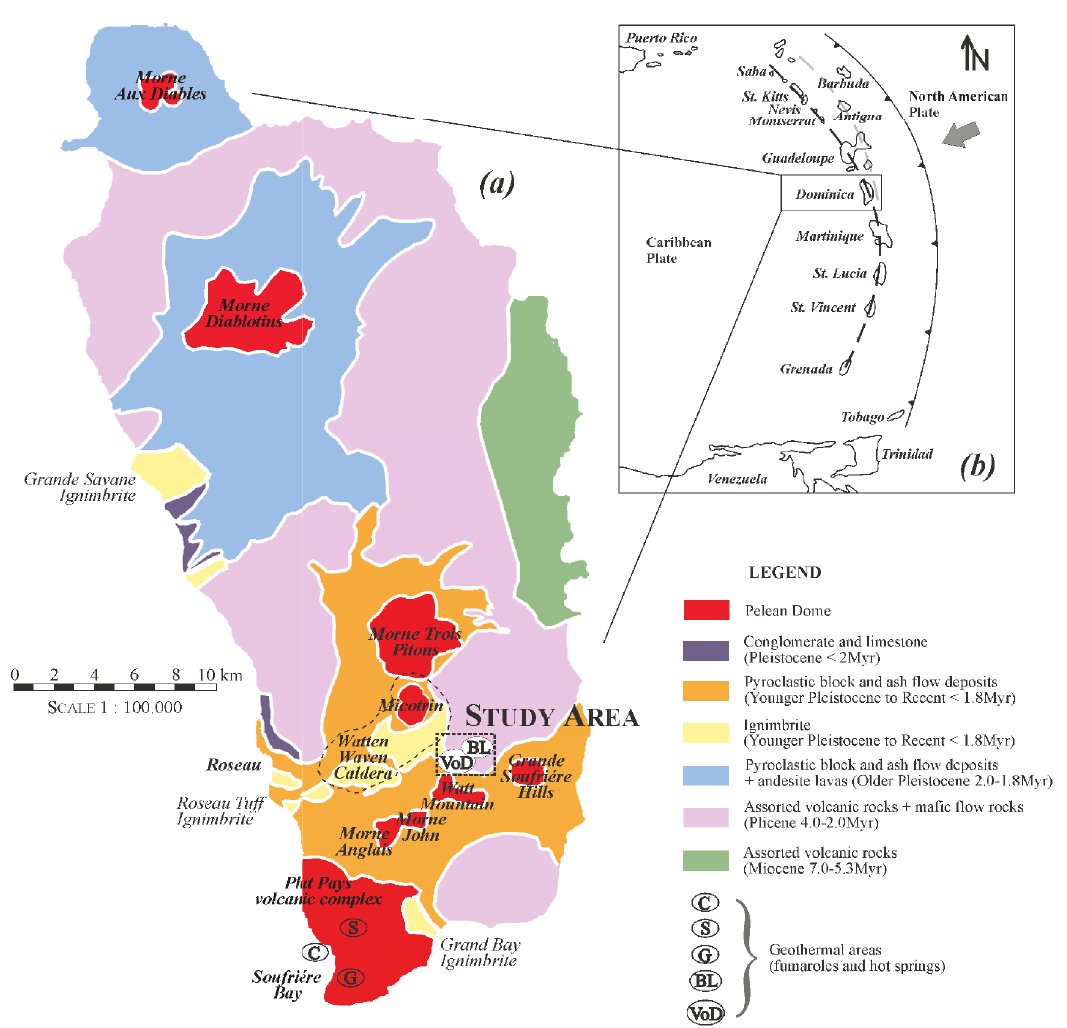
Figure 2. (a) Simplified geological map of Dominica (modified from Roobol and Smith [2005]); the inset (b) shows position of Dominica in the Lesser Antilles arc and simplified tectonic setting of the region (see